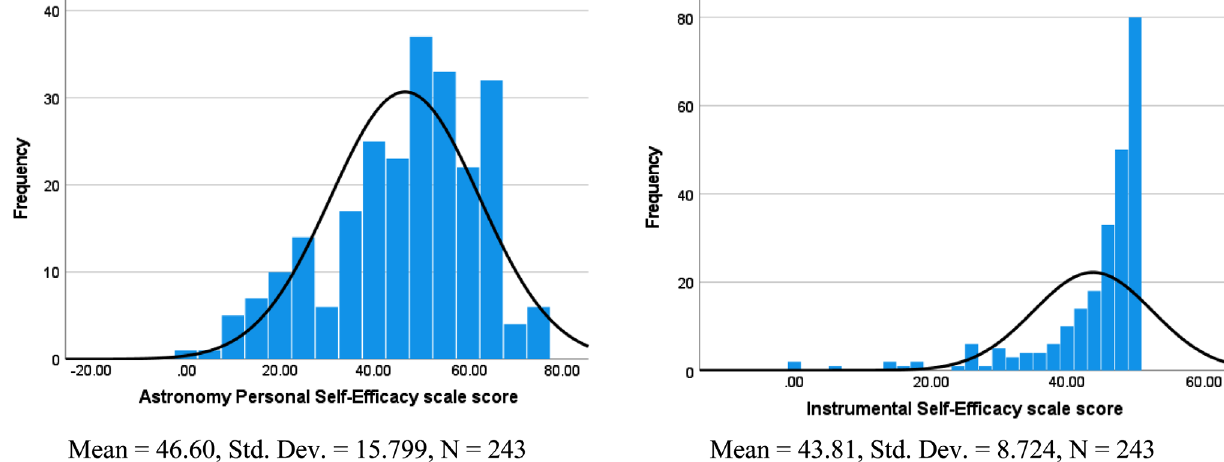
FIG. 3. Lab-group frequency distribution of the APSE (left) and ISE (right) for cohort A.